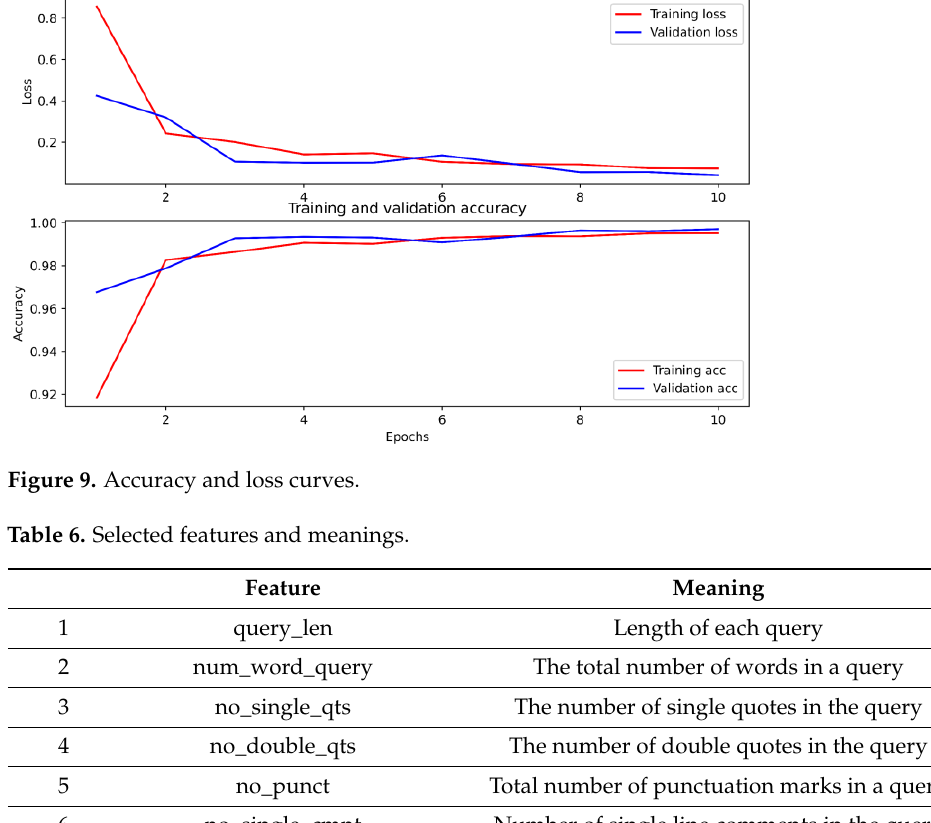
Table 6. Selected features and meanings.